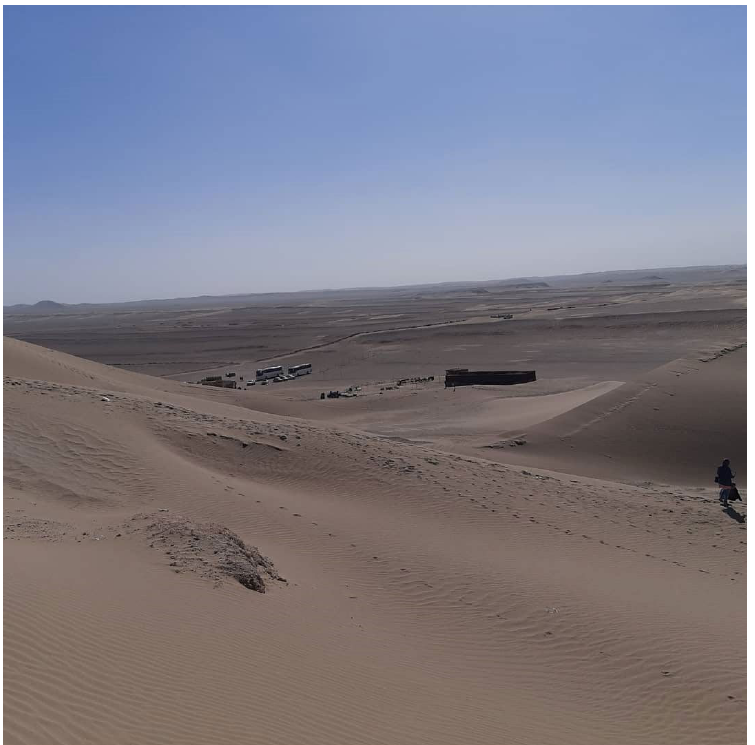
Figure 3. An example of a sightseeing, discovery, and socializing tourist activity with the impressive landscapes of large sandy accumulations and eco-camp facilities, part of the Black Mountain geosite (Photo source: J. Gorji ® ).